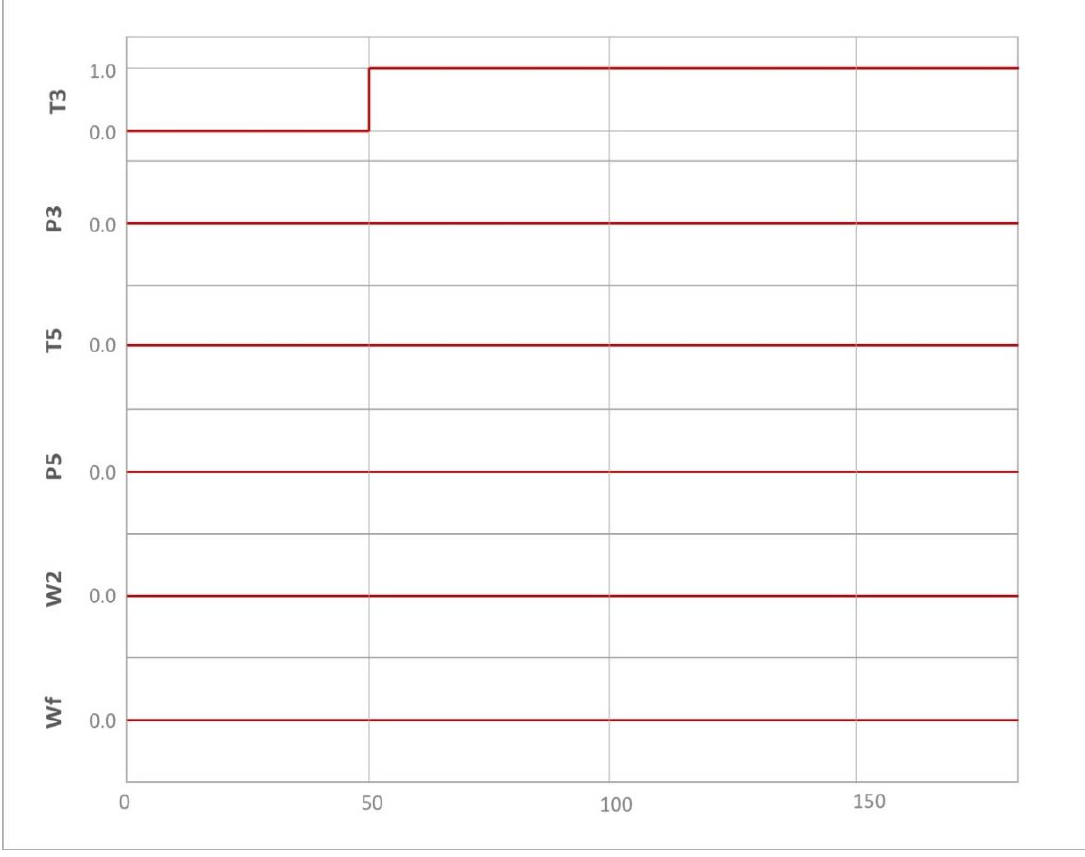
Figure 15. BN predictions of sensor status in Scenario 3 for P3 sensor fault. 0 means no fault and 1 means fault.